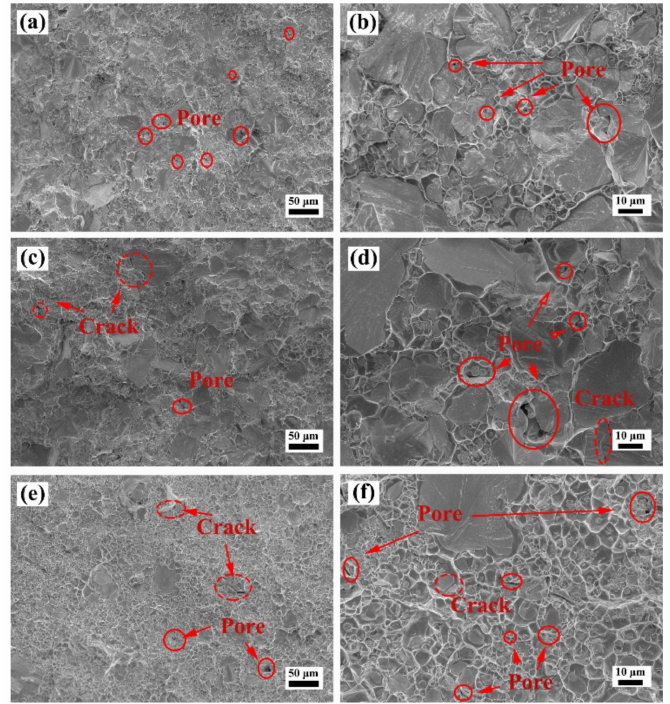
Figure 10. SEM images of the fracture surface of the ( a , b ) WY–G–10Cu, ( c , d ) WY–G–15Cu, and ( e , f ) WY–G–20Cu composites after bending